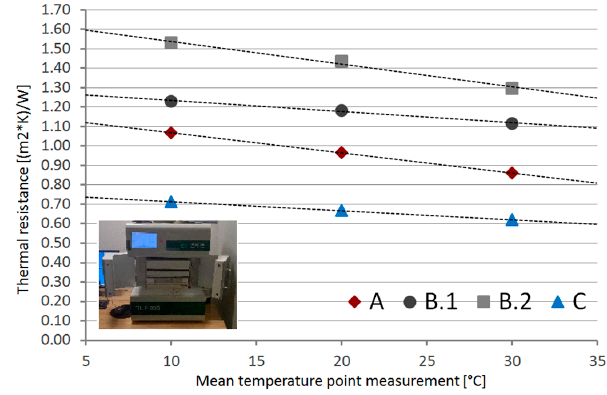
Figure 5. Thermal resistance results, guarded hot plate method.